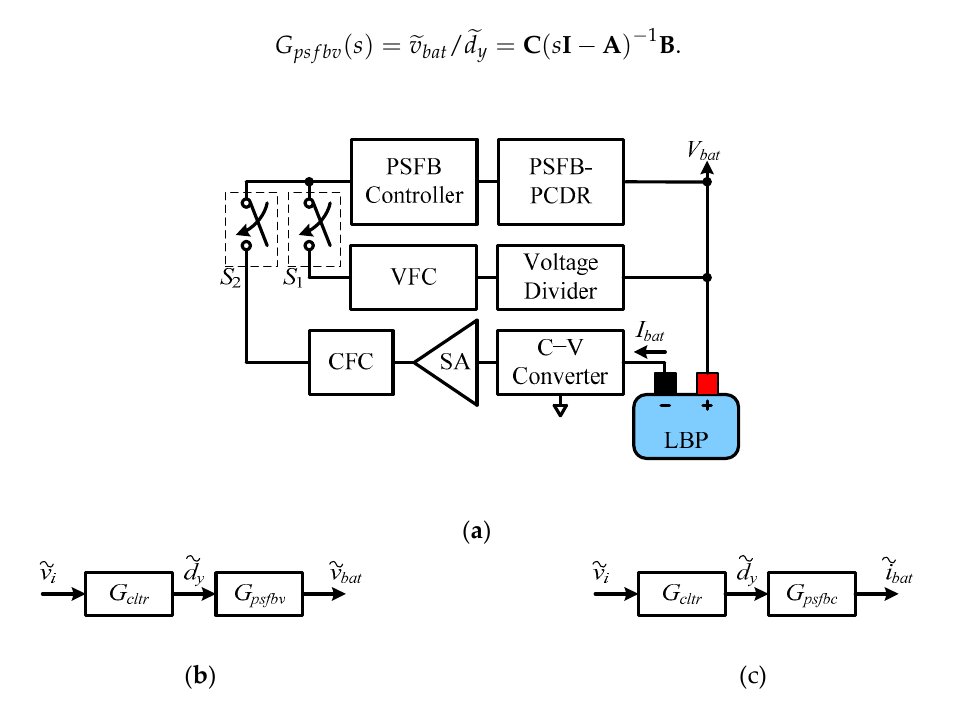
Figure 6. Charge system configuration. ( a ) System block diagram. ( b ) Block diagram for open-loop